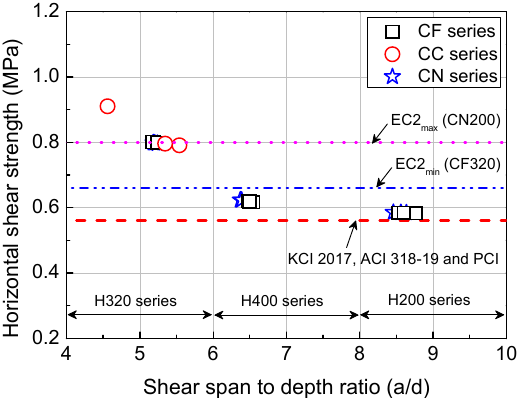
Figure 11. Comparison of horizontal shear strength according to shear span to depth ratio of HCS with topping concrete. with topping